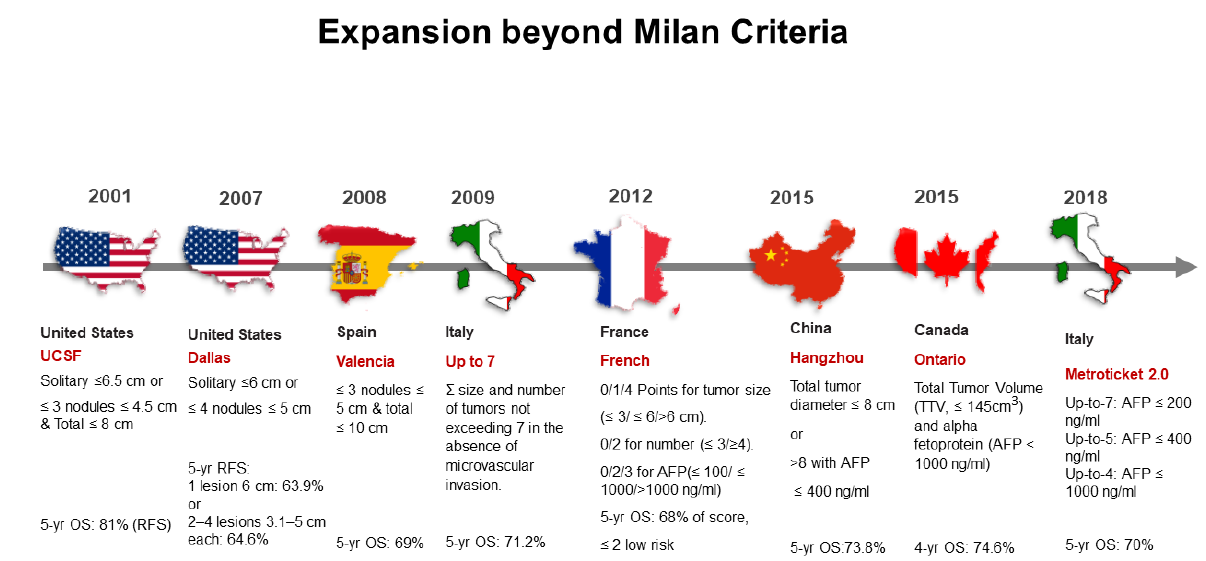
Figure 2. Historical expansions of the Milan criteria for liver transplantation in patients with hepatocellular carcinoma. yr: year; OS, overall survival; RFS, relapse-free survival; ∑ , summation; AFP, alpha-fetoprotein; TTV, total tumor volume; ml, milliliters; cm, centimeters; ng, nanograms.